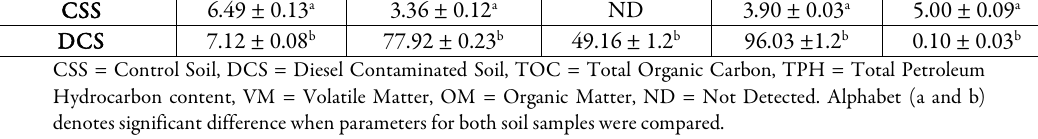
Table 1. Soil physicochemical parameters before bioremediation analysis Parameters pH TOC (%) TPH VM (%) OM (%) CSS 6.49 ± 0.13 a 3.36 ± 0.12 a ND 3.90 ± 0.03 a 5.00 ± 0.09 a DCS 7.12 ± 0.08 b 77.92 ± 0.23 b 49.16 ± 1.2 b 96.03 ±1.2 b 0.10 ± 0.03 b CSS = Control Soil, DCS = Diesel Contaminated Soil, TOC = Total Organic Carbon, TPH = Total Petroleum